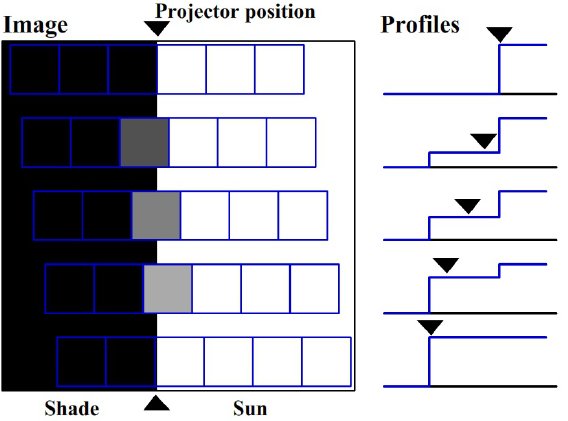
Figure 8. ( Left ) Simple image model with a projector along the center, where five different profiles are displayed. ( Right ) Intensity profiles for each case; we can see how the intensity of the transition pixel is related to the sub-pixel position of the projector (indicated by black